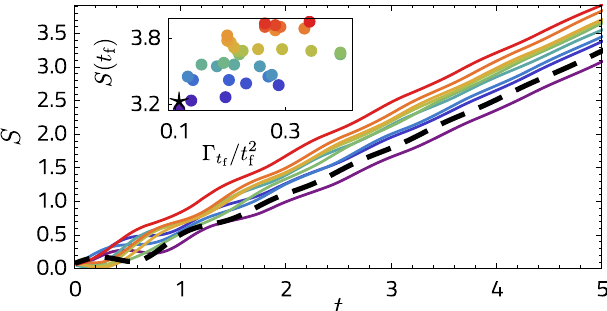
FIG. 7. Bipartite entanglement dynamics for different MPS initial states shows a strong dependence of entanglement growth on the initial state. The inset reveals that the amount of 5 is correlated with the MPS leakage entanglement at time t f ¼ =t 2 , where the periodic averaged over TDVP dynamics, Γ t f f trajectory is shown by star. Using initial conditions on the periodic trajectory results in slow entanglement dynamics (thick dashed line), but there are initial conditions that give even slower entanglement growth. The data are obtained with iTEBD with a maximum truncation error of approximately 10 − 10